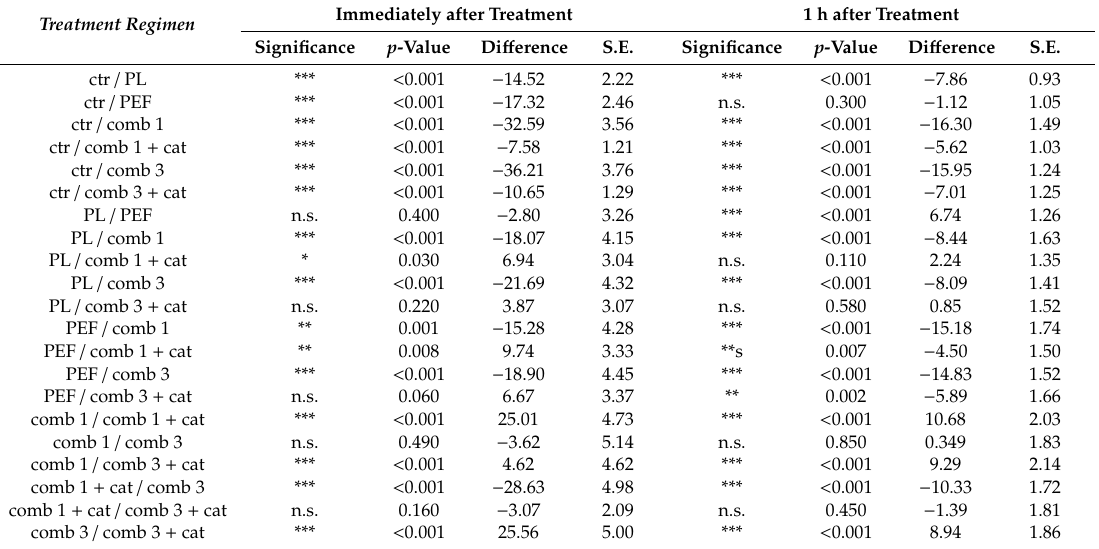
Table 4. Statistical analysis of lipid peroxidation immediately and 1 h after treatment. A multiple t-test was performed (* p < 0.05; ** p < 0.01; and *** p < 0.001). ctr = control; PL = plasma; PEF = pulsed electric fields; comb = combination; cat = catalase; n.s. = not significant. Treatment